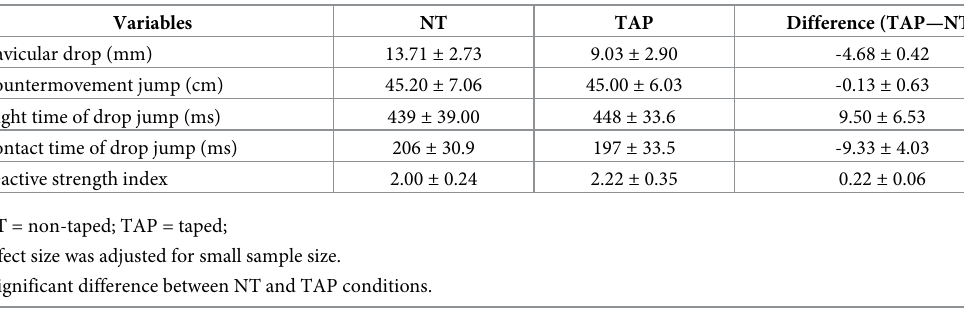
Table 1. Comparison between non-taped (NT) and taped (TAP) conditions in performance measures.